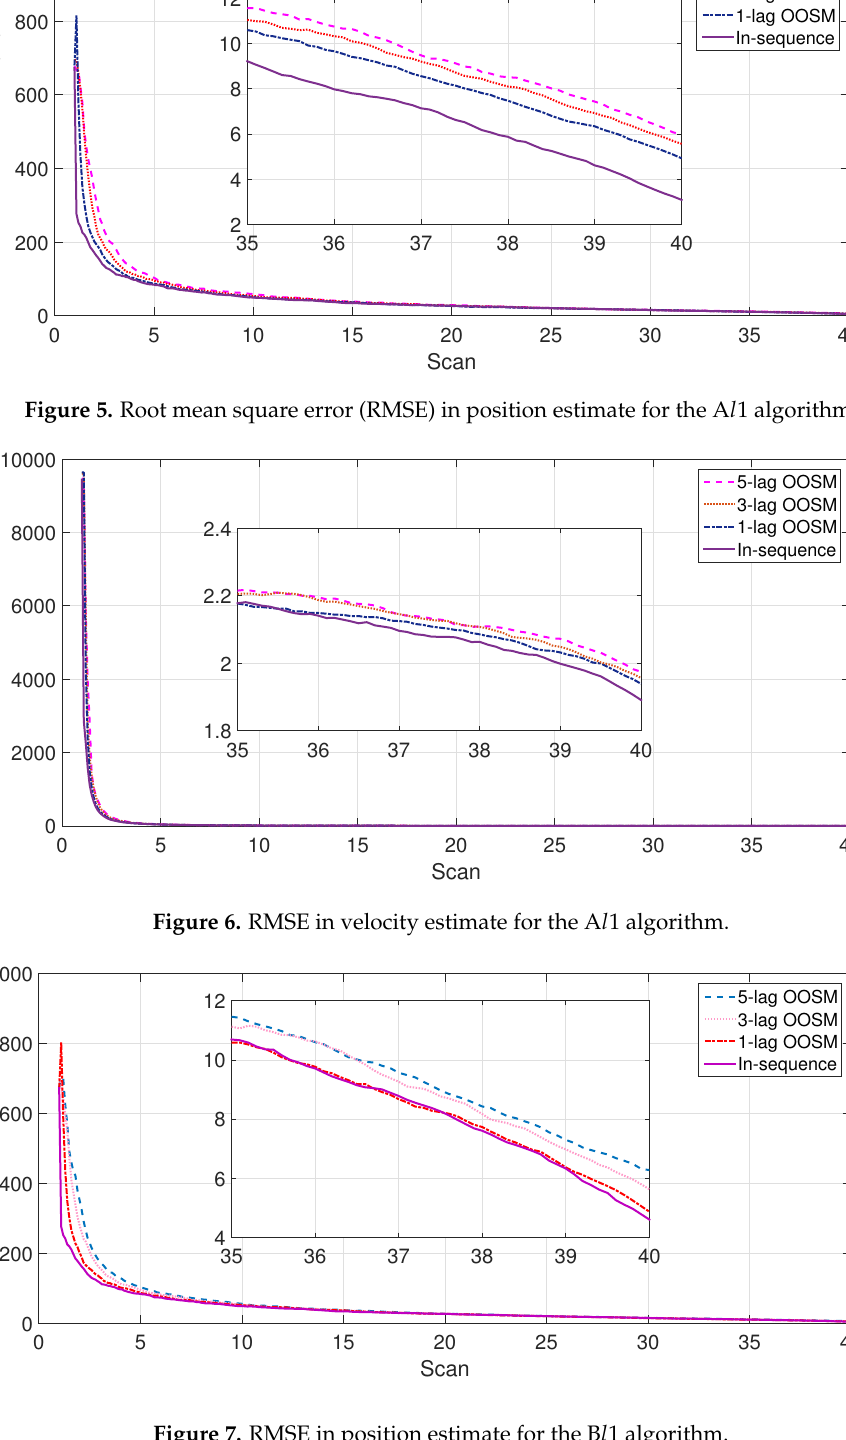
Figure 7. RMSE in position estimate for the B l 1